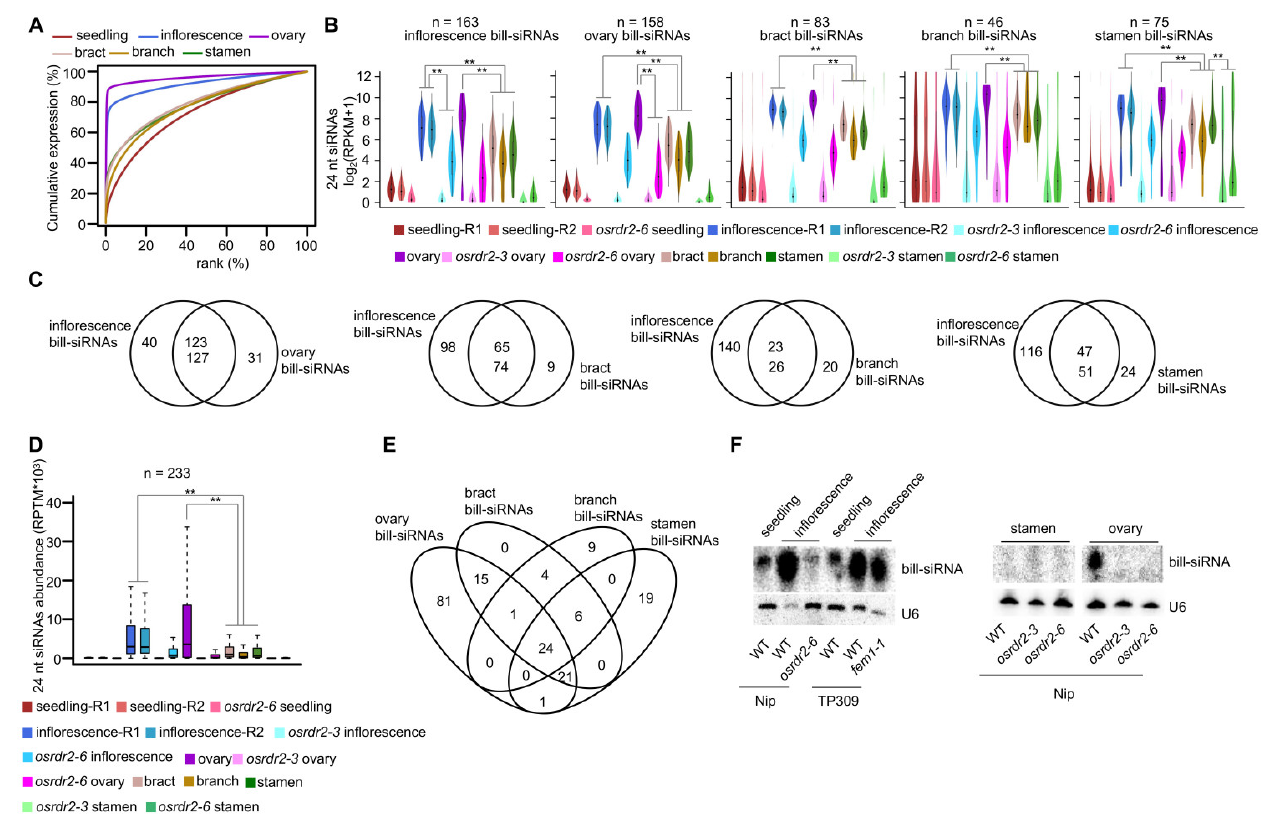
Figure 4. Bill-siRNAs in inflorescences are mainly derived from the ovary. ( A ) Cumulative expression plot of 24 nt siRNA clusters in seedlings, inflorescences, ovaries, bracts, branches, and stamens in Nipponbare. ( B ) Violin plots showing 24 nt siRNA abundance in different tissues on various genotypes on various bill-siRNA clusters. Quantile lines indicate the 1/4 and 3/4 percentiles. Black dots represent the median. ** indicates p < 0.01 by the Wilcoxon sum test. ( C ) Venn diagram indicating the overlap between bill-siRNAs in inflorescences and bill-siRNA clusters in the other four tissues. ( D ) Boxplot showing 24 nt siRNA abundance on the combined bill-siRNA clusters (inflorescences, ovaries, bracts, branches, and stamens) in various tissues. ** indicates p < 0.01 by the Wilcoxon sum test. ( E ) Venn diagram indicating the overlaps between bill-siRNA clusters in four tissues. ( F ) sRNA northern blotting indicating the sRNA levels of different tissues on one representative bill-siRNA cluster.